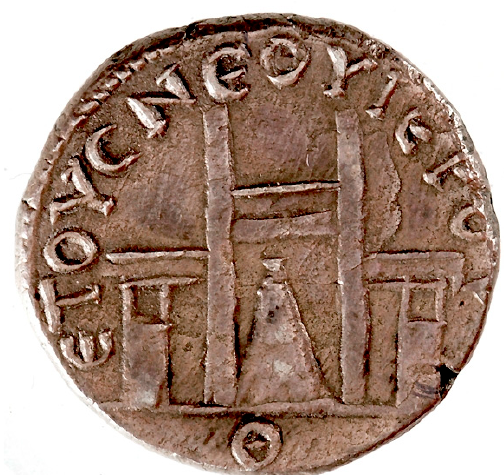
Figure 10. Reverse image of the Temple of Aphrodite at Palaipaphos on a silver tetradrachm minted under the authority of the emperor Vespasian for Cyprus (77–78 AD). Image courtesy of the American Numismatic Society.